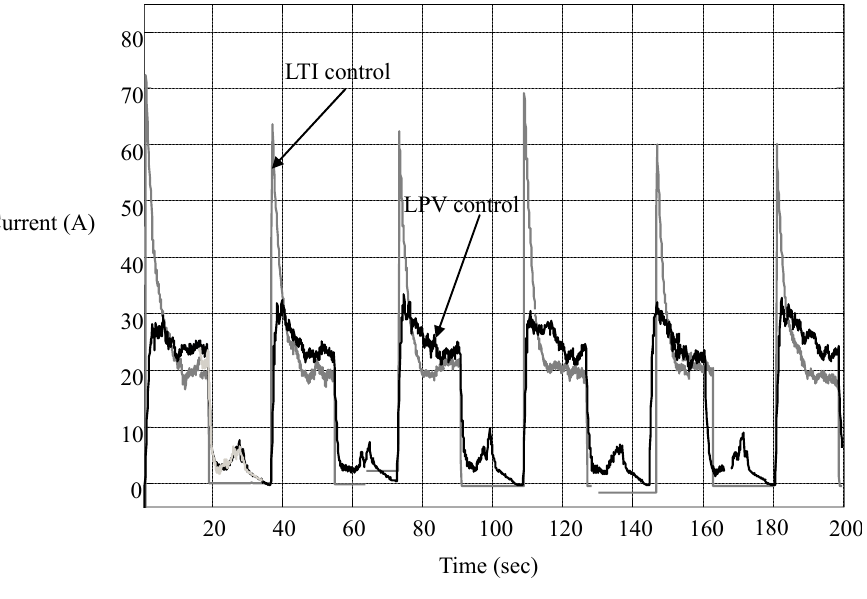
Figure 13. Current responses in LTI and LPV controls.